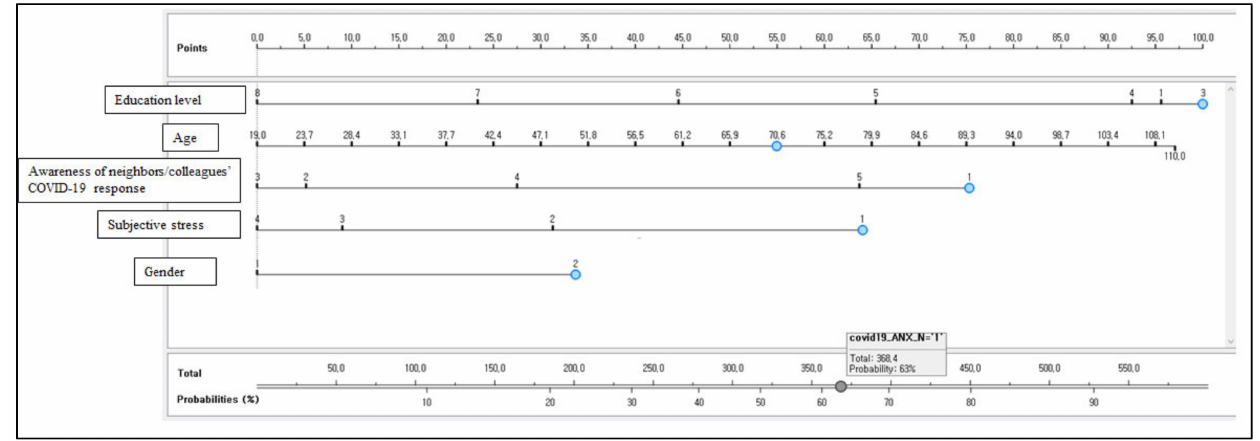
Figure 5. Anxiety prediction nomogram due to COVID-19 for South Korean adults (n =